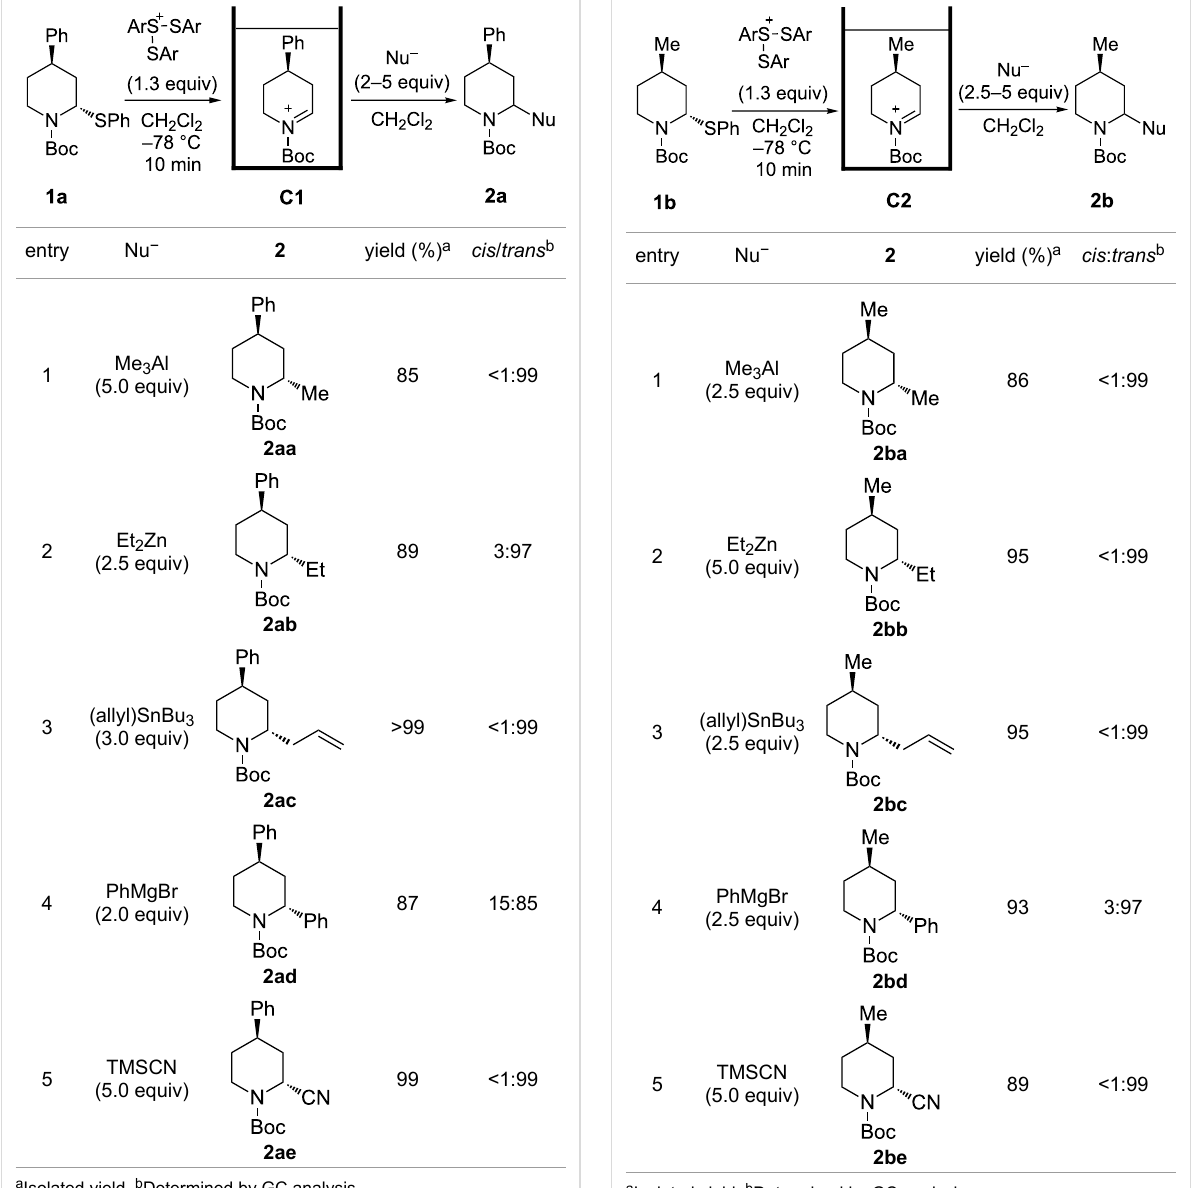
Table 1: Reaction of N- acyliminium ion C1 with several nucleophiles. Table 2: Reaction of N- acyliminium ion C2 with several